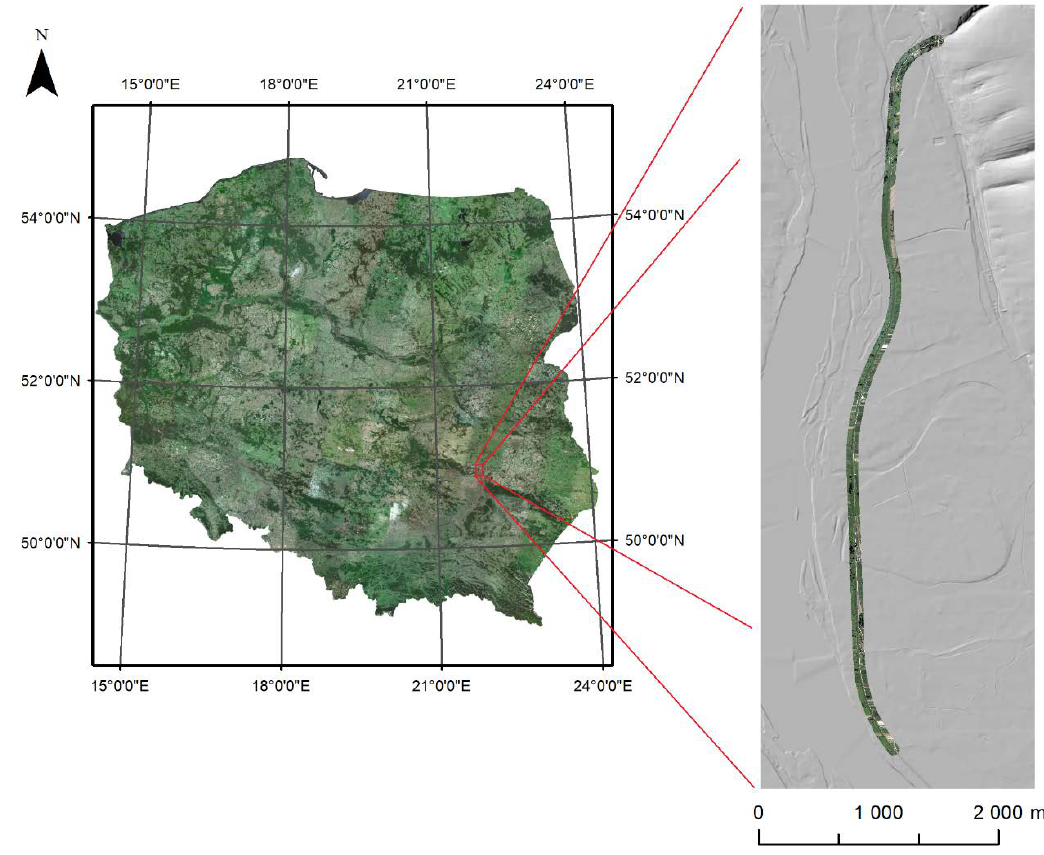
Figure 2. Levee test area in Annopol near the Vistula River (red filled polygon), presented on the orthophoto.